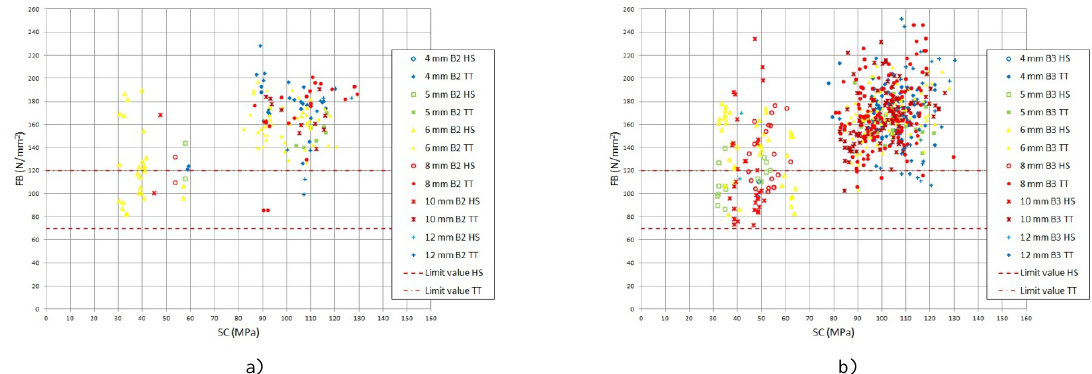
Fig. 7 Correlation of surface compressive stress (SC) versus flexural bending (FB): a) for B2 coated glass; b) for B3 coated glass.